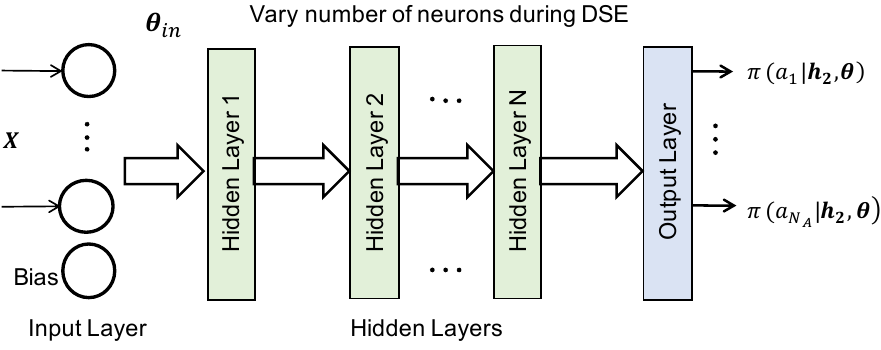
Figure 4. Design space exploration for neural network